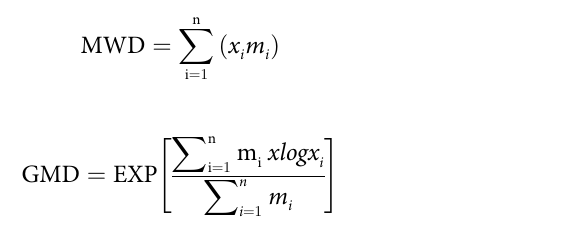
where n is the number of aggregate size fractions, x R was calculated as follows [21]: 0.25